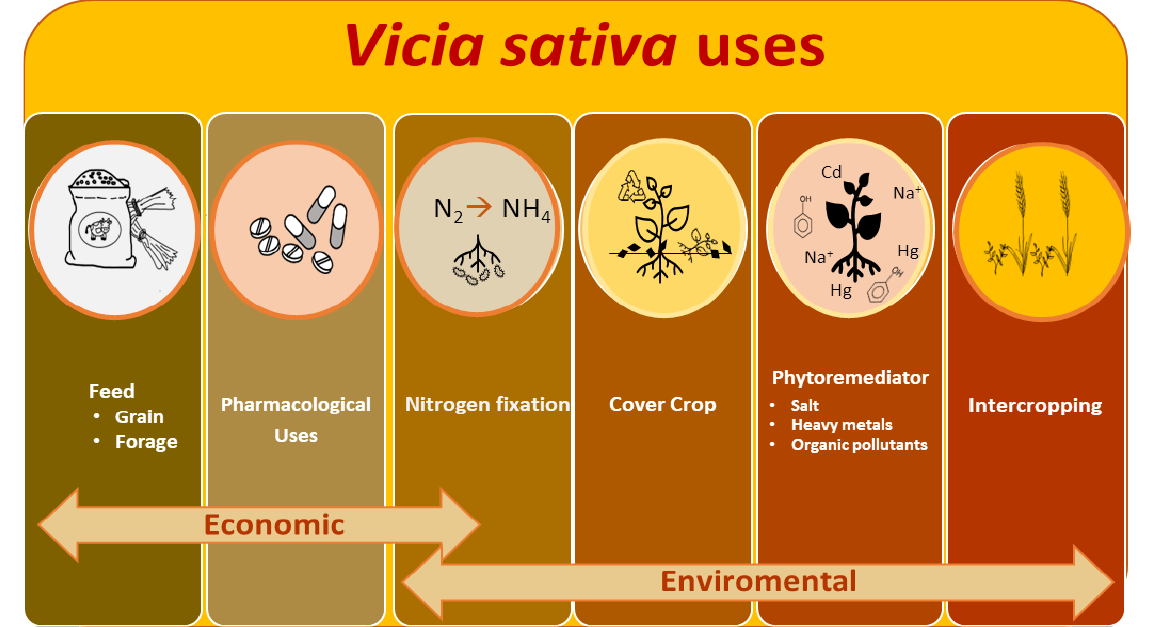
Figure 1. V. sativa main uses. The scheme includes economically relevant nutritional and medical uses. Environmental applications for sustainable agriculture systems are also incorporated.